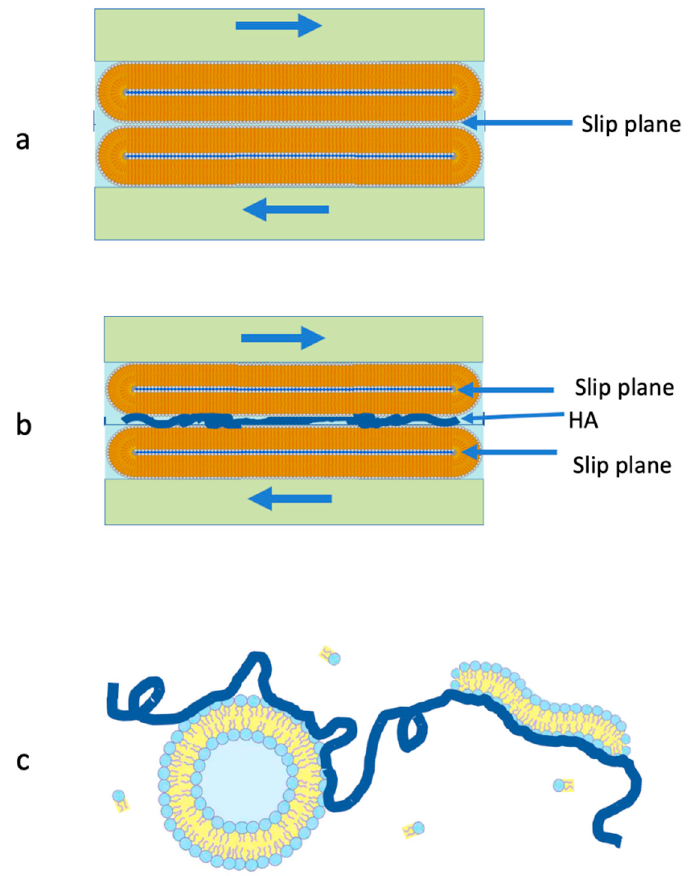
Figure 7. Illustrating the two mechanisms which are attributed to enable low friction hydration lubrication between PC-coated layers, even in the presence of HA. ( a ) In the case of the gel-phase lipid layers (HSPC) in HA-free water, the slip plane is the mid-plane between the vesicles. ( b ) When HA is added, it may adsorb on the vesicles’ surfaces to bridge the gap between them, leading to high friction at the mid-plane interface. As a result, the slip plane shifts, as shown, to the inner interfaces, where hydration lubrication is unhindered by the HA bridging. ( c ) In the case of the liquid-phase POPC, where the surfaces are immersed in a POPC dispersion (see text), the addition of HA leads to interactions between the lipids in solution and the polysaccharide, as indicated; this suppresses their adsorption on the surface-attached POPC bilayers and thus enables hydration lubrication between them, unhindered by any HA bridging.